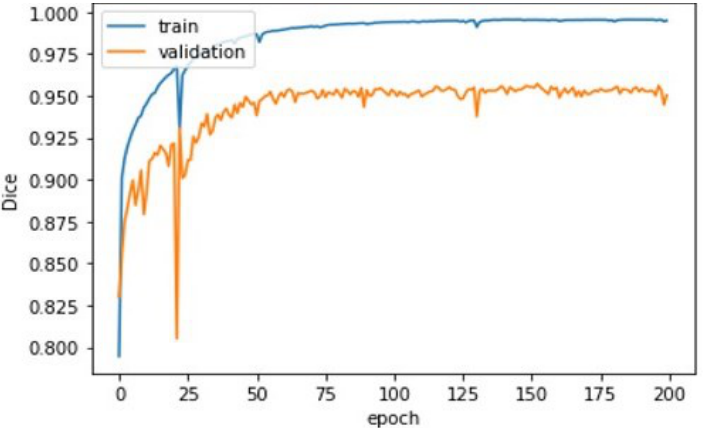
Figure 10. (Blue) Evolution of the Dice score for 70 volumes from the SKI10 database and (Orange) evolution of the Dice score for the validation set relative to the number of